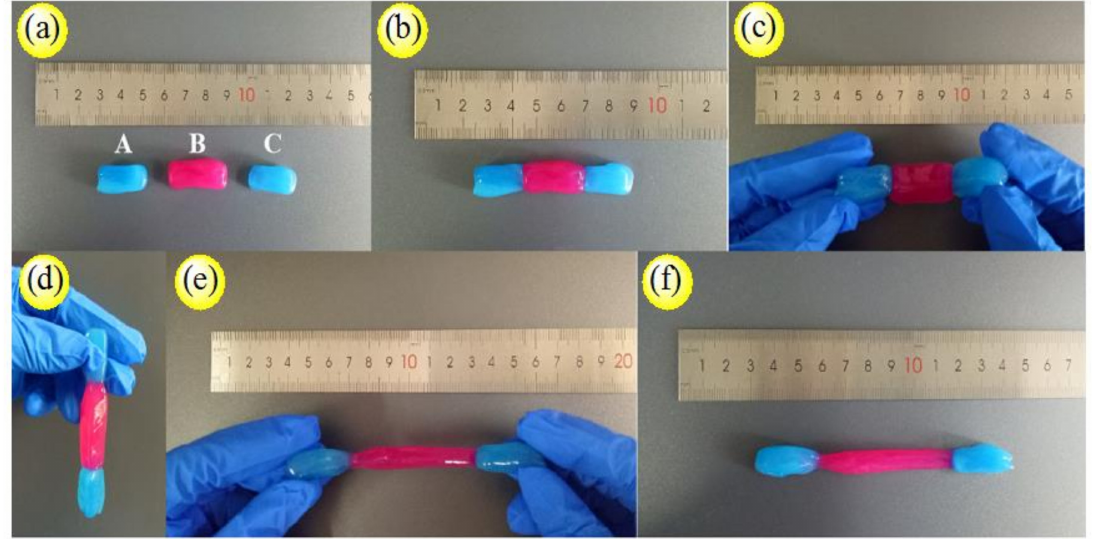
Figure 13. Behavior of PVA / CNC-UPy / FA composite hydrogels ( a ) three colors of hydrogelswere prepared, ( b ) three di ff erent hydrogels were placed together, ( c ) three parts of the hydrogels were bonded, ( d ) the healed hydrogels cannot be separated, ( e ) the ends of hydrogels were stretched and they grew longer, ( f ) two colors permeated each